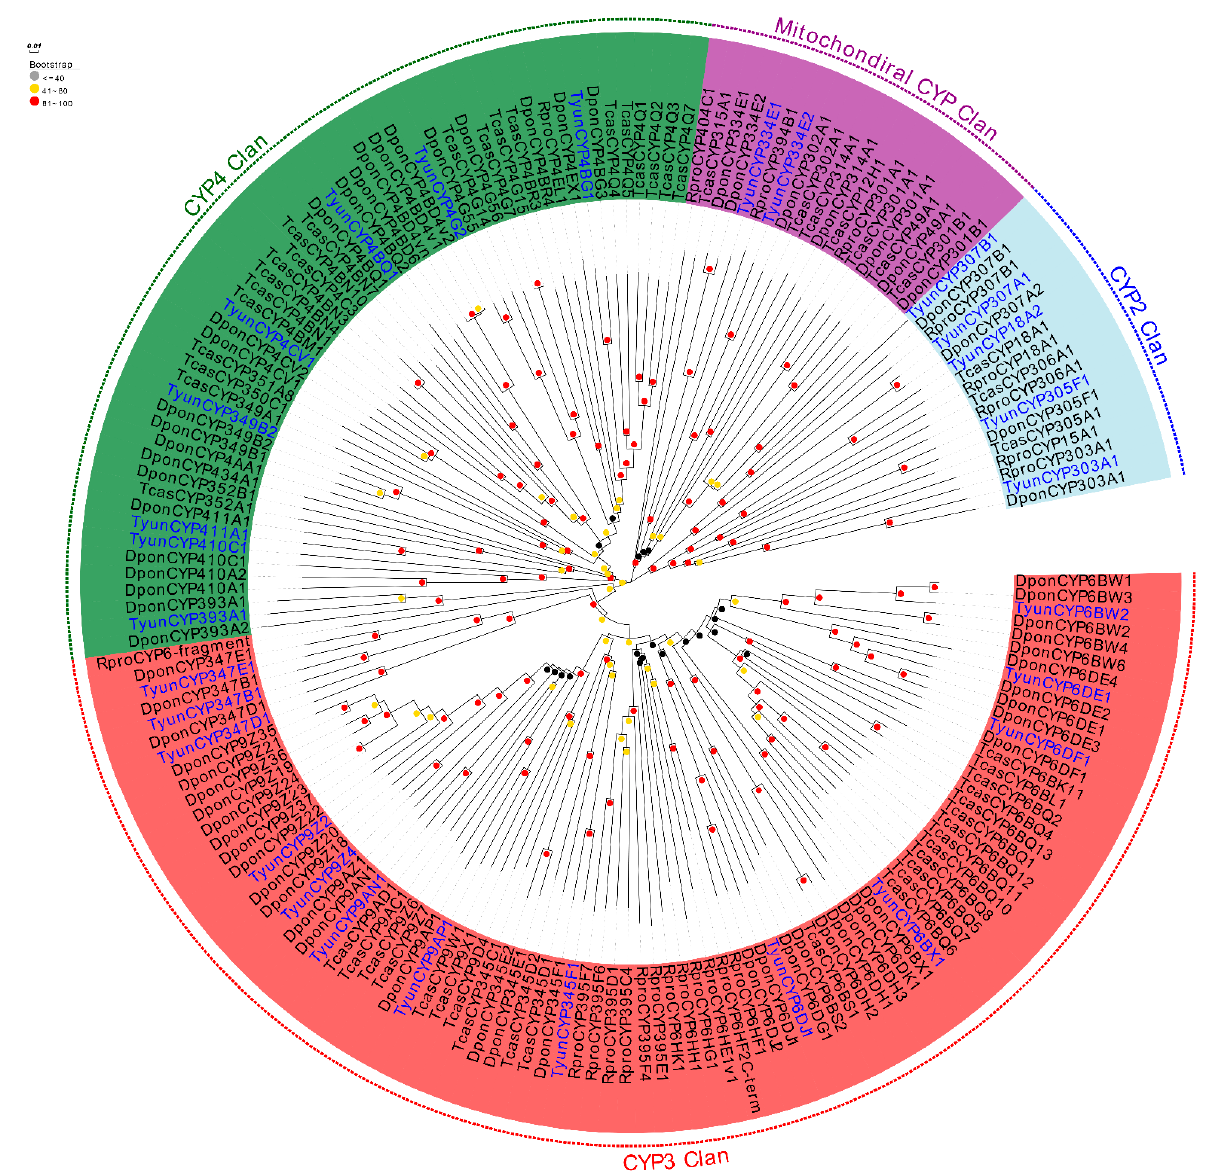
Figure 3. Neighbor-joining tree of candidate CYPs. Bootstrap values after 1000 replications. Dpon, Dendroctonus ponderosae ; Rpro, Rhodnius prolixus ; Tcas, Tribolium castaneum ; Tyun, Tomicus yunnanensis .